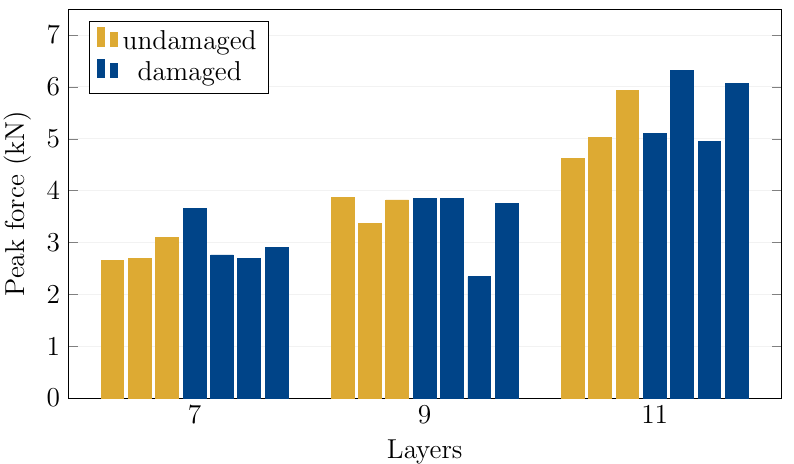
Figure 6. Comparison of peak forces between the undamaged and damaged